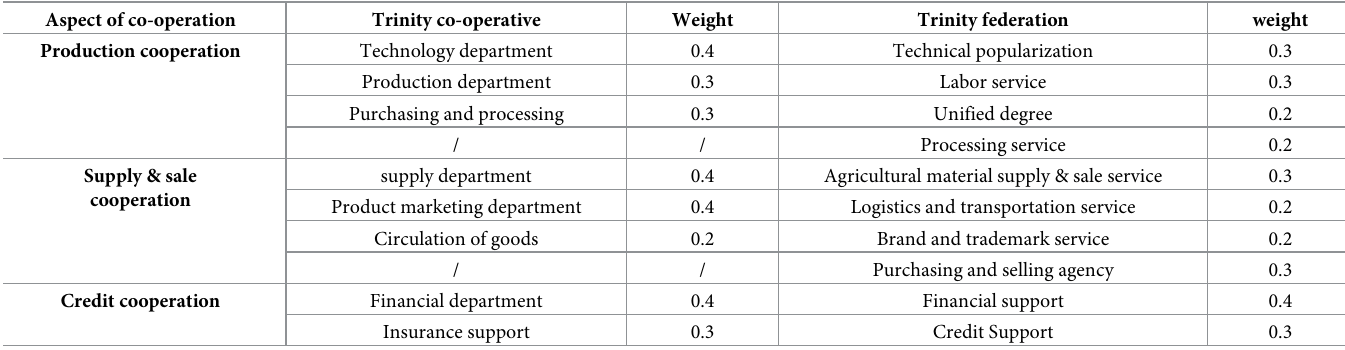
Table 2. Second-level condition variables and their weights.